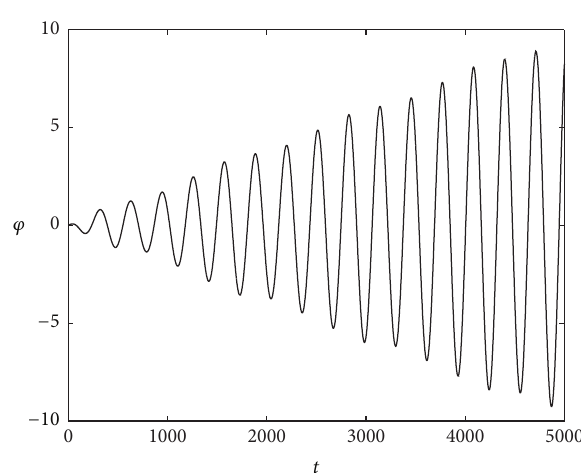
Figure 3: Time history for the solution 𝜑